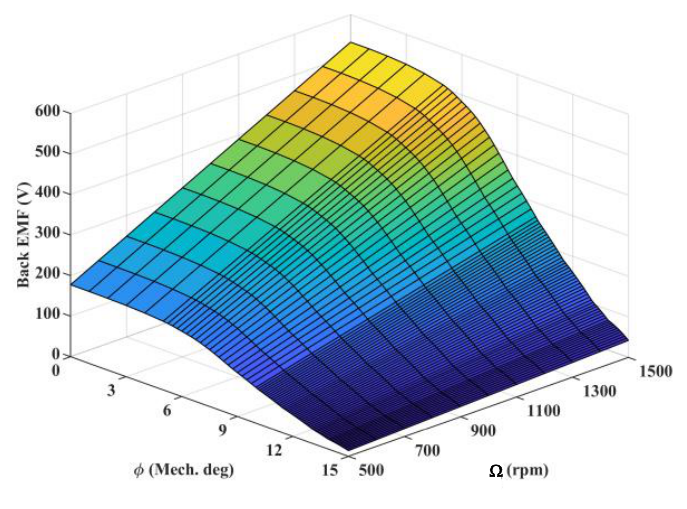
Figure 15. The relationship of back EMF, initial phase angle, and rotating speed of the rotor.